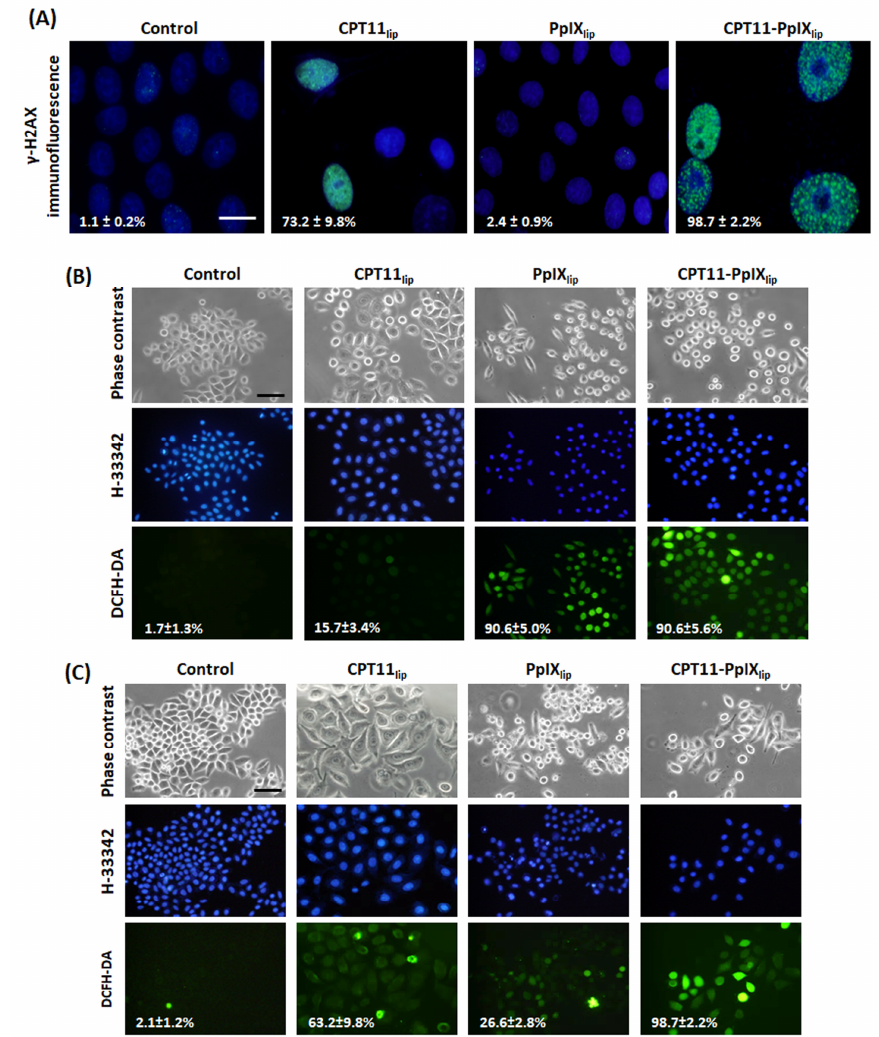
Figure 5. Action mechanisms of the different photodynamic treatments. ( A ) Representative images of indirect immunofluorescence for γ -H2AX (green) and H-33258 counterstaining of DNA (blue) in control or photodynamic treated cells 72 h after irradiation and the percentage of cells with double- strand DNA breaks. Scale bar: 20 μm. ( B , C ) Representative images of reactive oxygen species (ROS) generation in control cells and cells submitted to the different photodynamic treatments, analyzed by the DCFH-DA probe 2 h ( B ) and 24 h ( C ) after irradiation. Cells were visualized under phase contrast microscopy or fluorescence microscopy for the DCFH-DA probe (green). Scale bar: 50 μm. To further understand the mechanisms of action of the different liposomes, an anal- ysis with the 2,7-dichlorodihydrofluorescein diacetate (DCFH-DA) probe for the detection